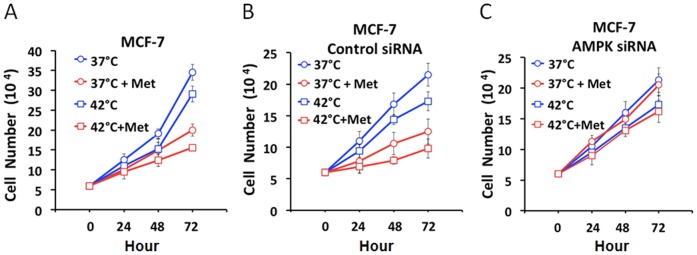
Proliferation of MCF-7 human breast cancer cells treated with hyperthermia and metformin.Numbers of viable cells (trypan blue excluding cells) were counted with a hemocytometer after incubations for 0–72 h. (A) 37°C; incubated in regular medium. 37°C + Met; incubated in medium containing 5 mM metformin. 42°C; heated at 42°C for 1 h in regular medium and incubated. 42°C + Met; heated at 42°C for 1 h and incubated in medium containing 5 mM metformin. The variances in cell numbers among the 4 groups at 72 h were statistically significant (ANOVA). The cell number of 42°C + Met group was statistically smaller than that of 37°C + Met group by student t-test. (B, C) MCF-7 cells were transfected with control siRNA or AMPK siRNA and the effects of metformin and heating or combined on cell proliferation were studied. Effect of siRNA to suppress the effect of metformin alone or in combination with heating was statistically significant.